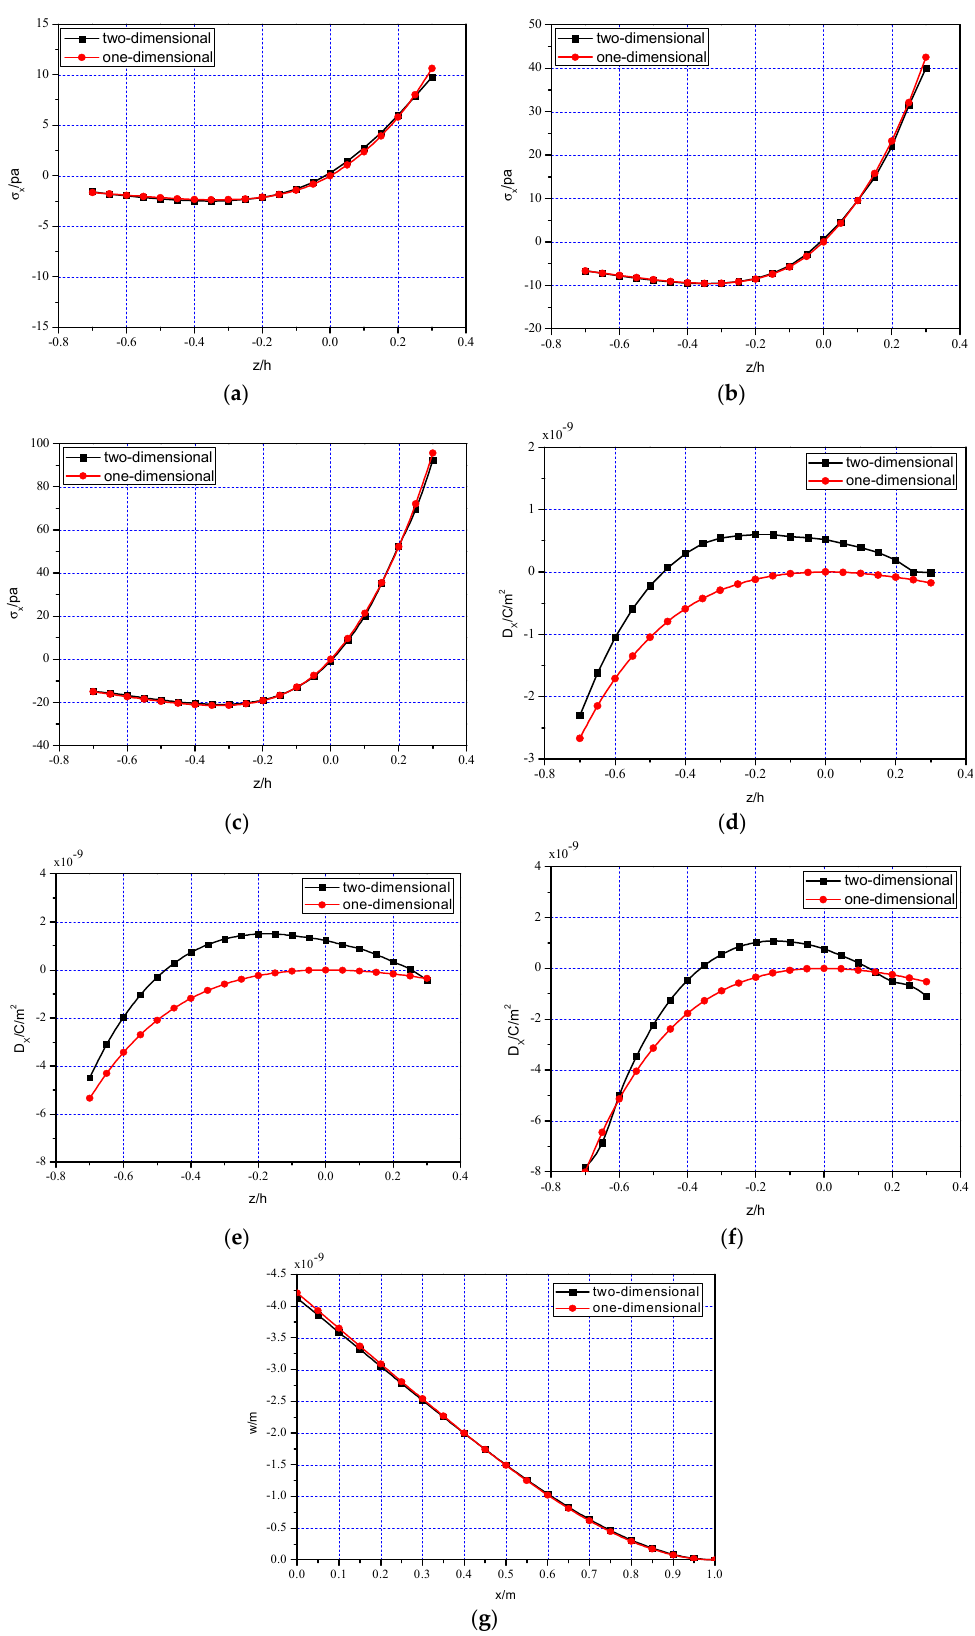
Figure 7. Comparisons of one-dimensional solution and two-dimensional simulation: ( a ) σ x at x = 0.25 l ; ( b ) σ x at x = 0.5 l ; ( c ) σ x at x = 0.75 l ; ( d ) D x at x = 0.25 l ; ( e ) D x at x = 0.5 l ; ( f ) D x at x = 0.75 l ; ( g ) w ( x ) at z =